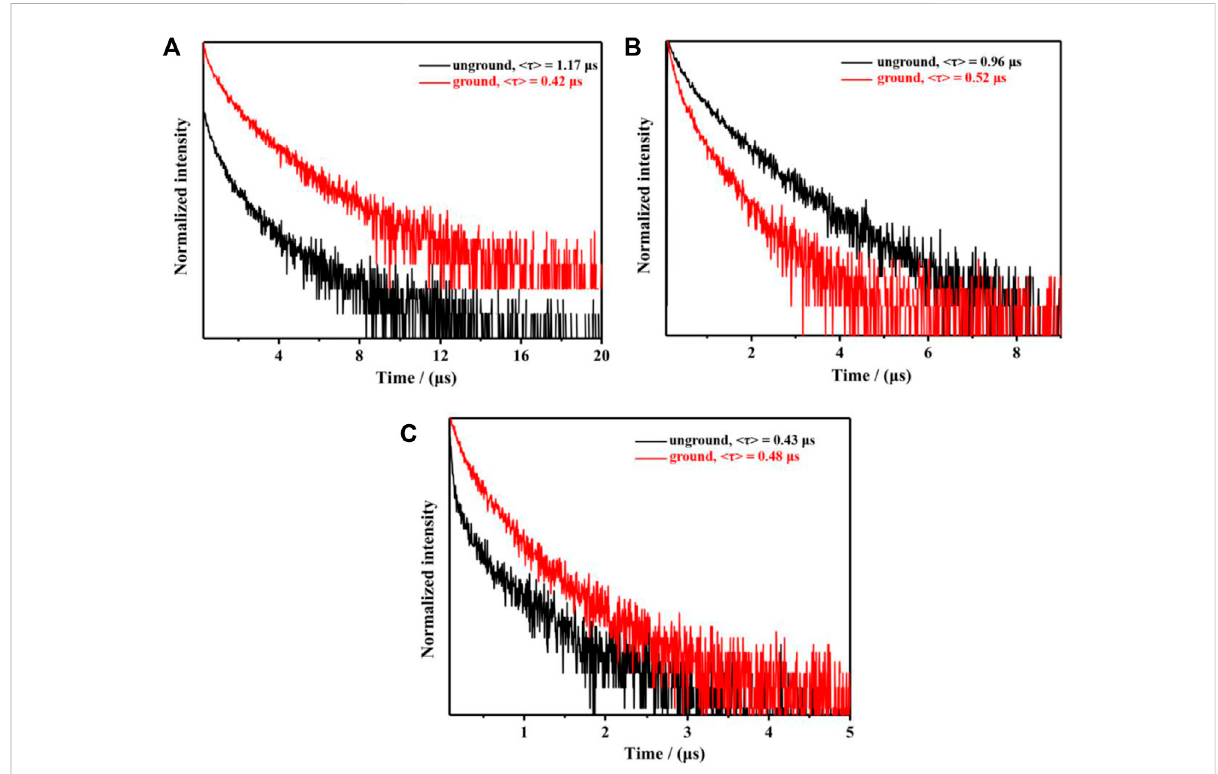
FIGURE 5 Decay curves of complexes 1 (A) , 2 (B) , 3 (C) in different solid state.